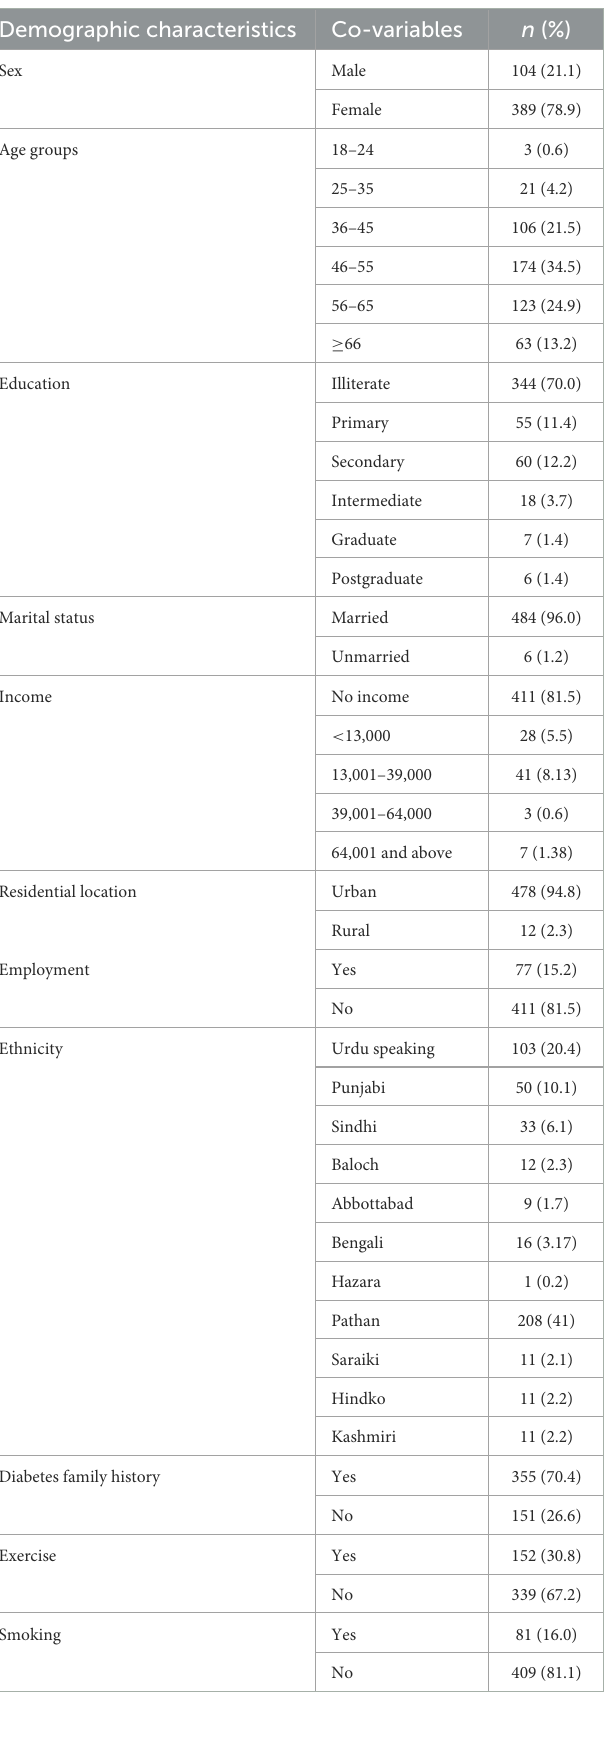
TABLE 2 Clinical and psychosocial characteristics of patients with diabetes mellitus attending the outpatient department at SINA